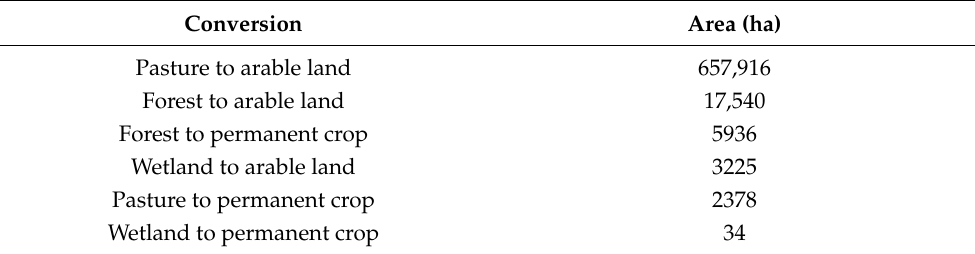
Table 1. Adverse Land cover changes in EU agriculture from